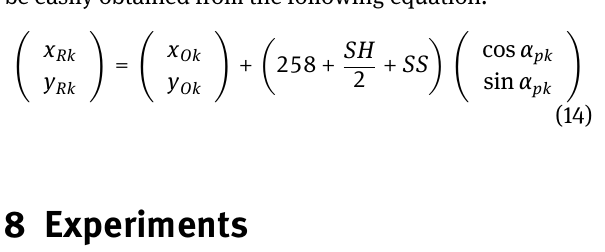
Table 4. Settings of Projection Screen in Three Kinds of Distance